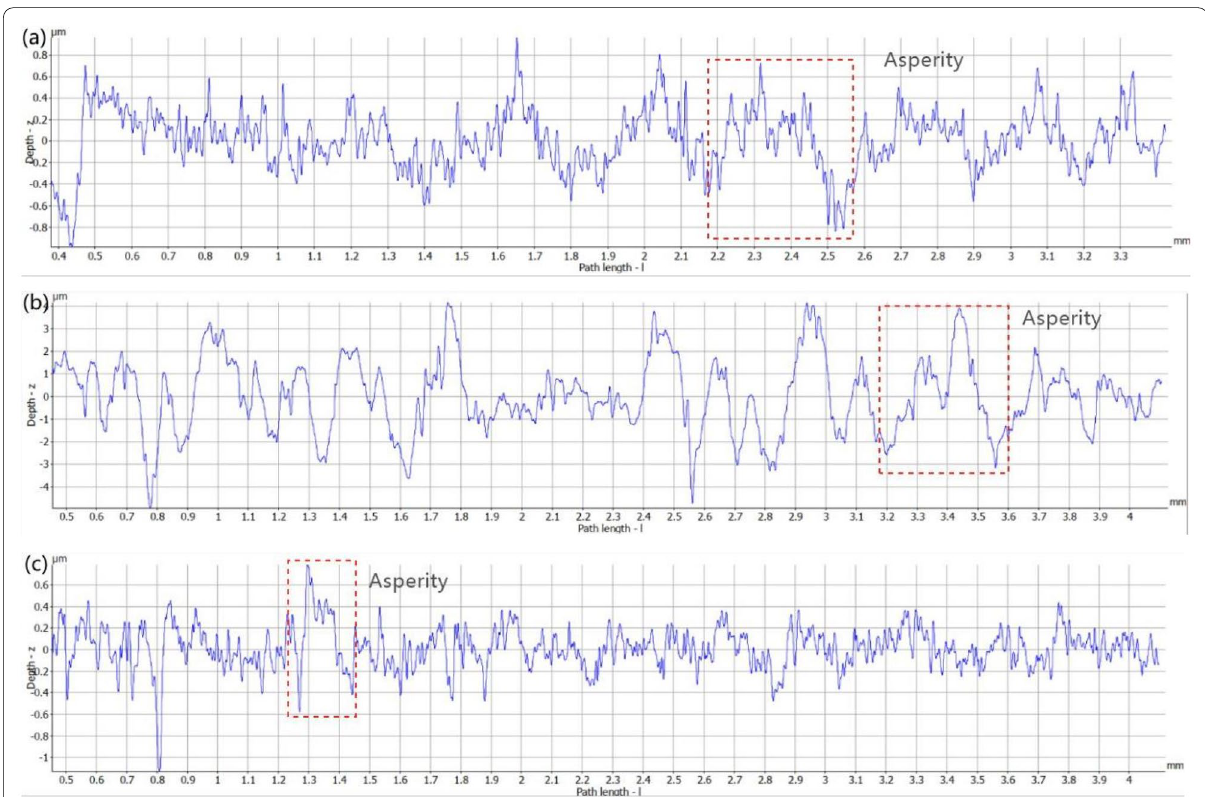
Figure 12 The surface roughness of the a AsR, b SP and c USRP